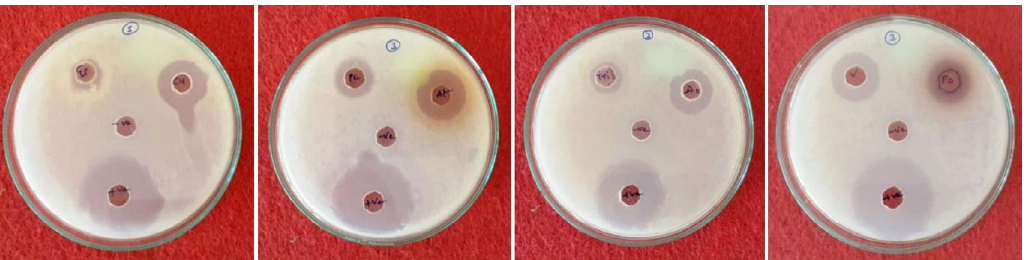
Fig. 5. Screening of endophytic fungi for Antimicrobial